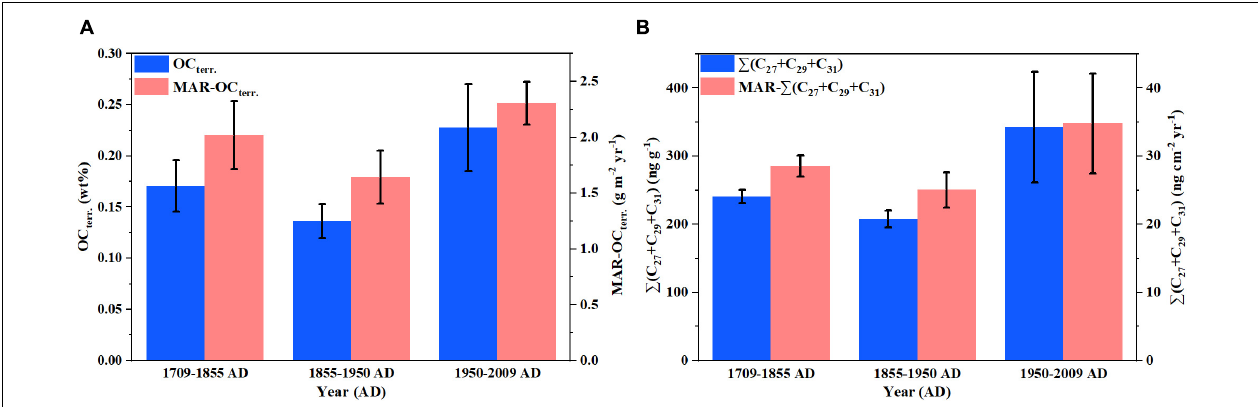
FIGURE 8 | Content and mass accumulation rates (MAR) of terrestrial OC (A) and long-chain n -alkanes (B) , i.e., (cid:54) (C 27 + C 29 + C 31 ), from core HH12 during different time intervals. The content and mass accumulation rate of terrestrial OC were calculated using δ 13 C binary mixing model. The error bar represents associated 1 σ uncertainty. Content of long chain n -alkanes was expressed in ng per g dry sediment (ng g − 1 ). According to the t -test statistical analyses performed on software package SPSS 22 (IBM), there exist significant differences ( p < 0.05) of data among the time intervals. Therefore, temporal changes of terrestrial OC and biomarker with respect to the time intervals of 1709-1855 AD, 1855-1950 AD, 1950-2009 AD are